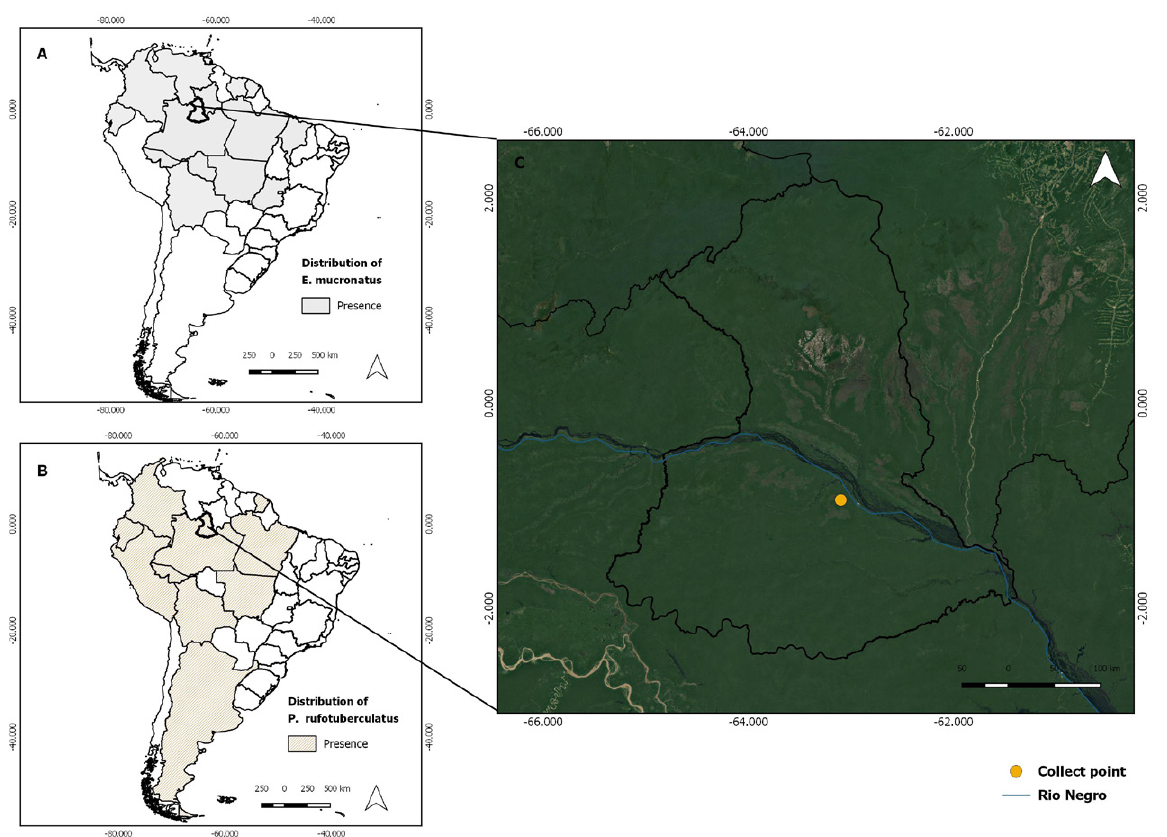
Figure 1. Maps showing the distribution of ( A ) Eratyrus mucronatus and ( B ) Panstrongylus rufotuberculatus . C. Location of the riverside community of Piloto, Barcelos, Amazonas,